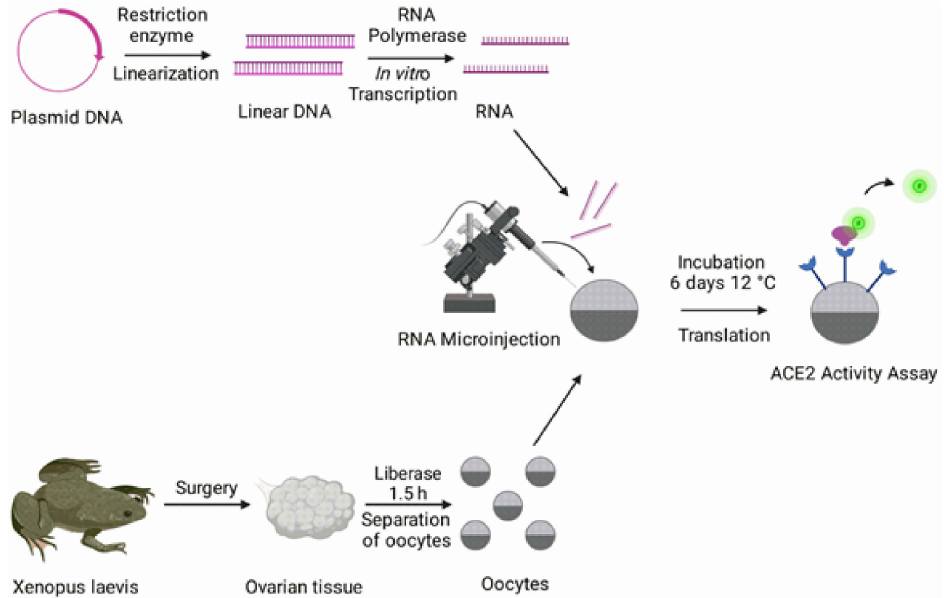
Figure 1. Overview of the methodology for fluorometric ACE2 activity measurements in Xenopus laevis oocytes. See Methods for detailed steps. The image was created with Biorender.com (accessed on 10 August